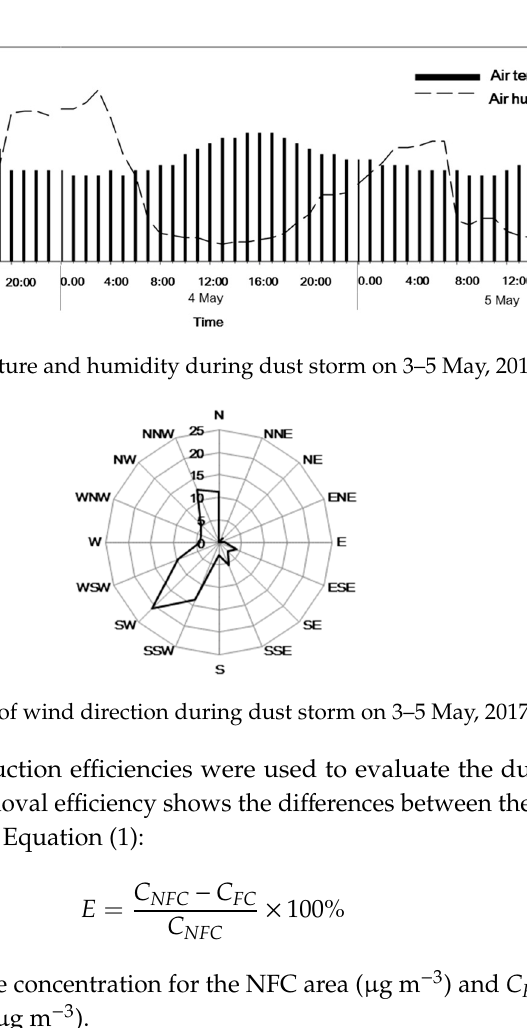
Figure 3. Frequency of wind direction during dust storm on 3–5 May, 2017 in Beijing.